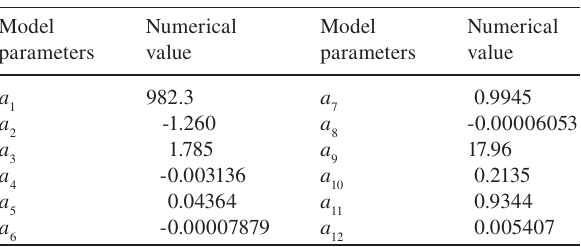
Table 1 Parameters of the constitutive model for the CR-1018